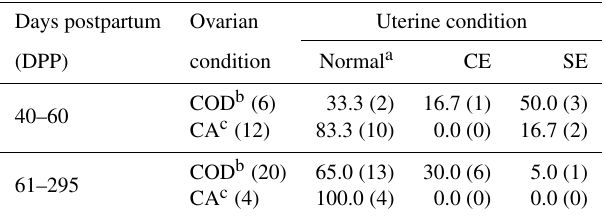
Table 1. Prevalence of clinical endometritis (CE) and subclinical endometritis (SE) in Japanese Black cattle diagnosed with vaginal mucus test and endometrial cytology. In parentheses is the number of